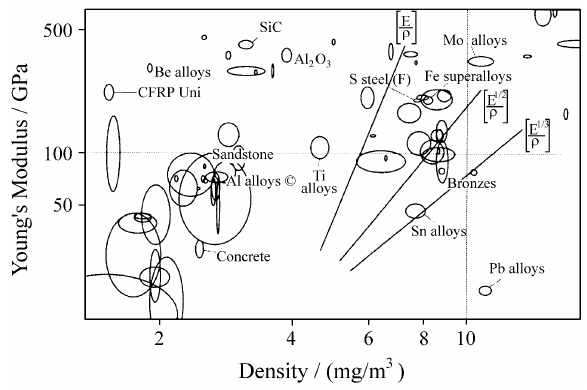
Figure 3. Material Property Map for Young modulus and density 5 . For clarity only some materials were labelled. It can be seen that for the same performance a steel tie working in tension (E/ ρ ) will be heavier than one made of titanium. However, orthogonal reading reveals that the latter will have a much larger cross section than the former.